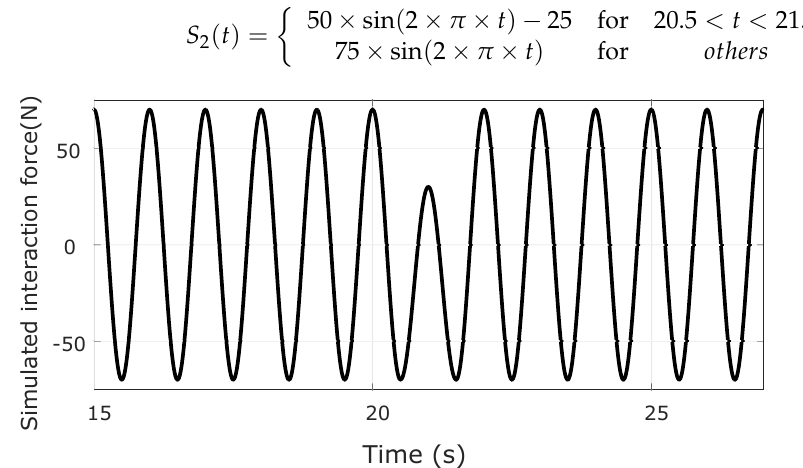
Figure 4. Simulated signal with transient changing